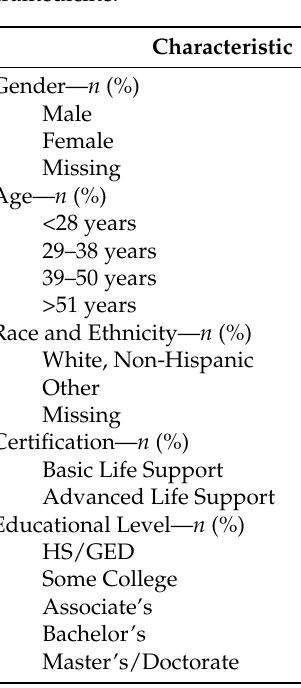
Table 1. Demographic of participants. Abbreviations: HS/GED, high school/General Educa- tional Development; IQR, interquartile range; MIHCP, Mobile Integrated Healthcare or Community